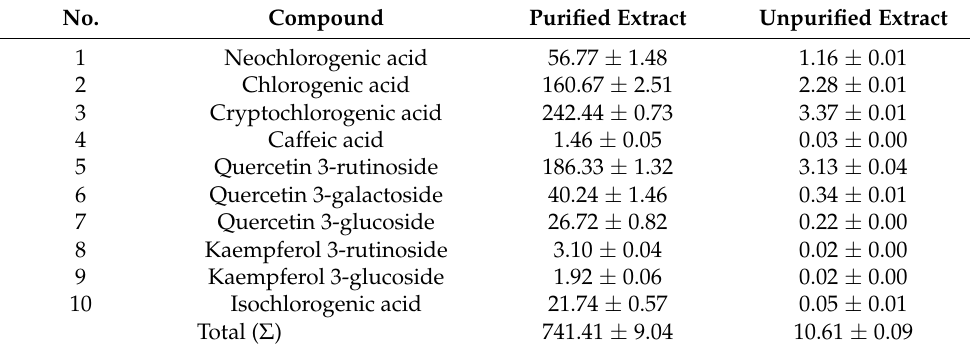
Table 6. Contents ( µ g/mg) of the 10 analyzed polyphenolic compounds. No.